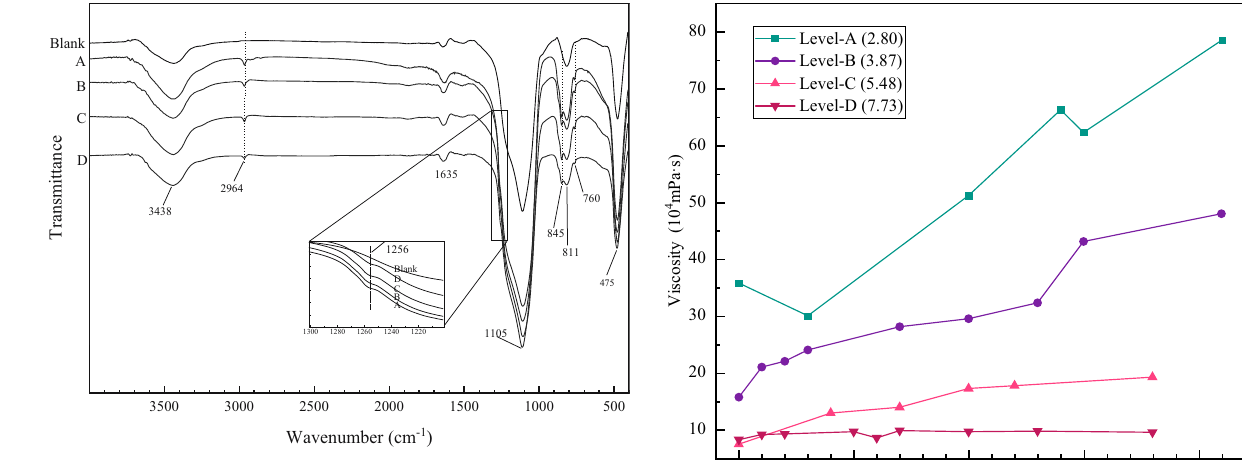
Figure 3: Fourier transform infrared spectra of Aerosil 200 and three kinds of treated fumed